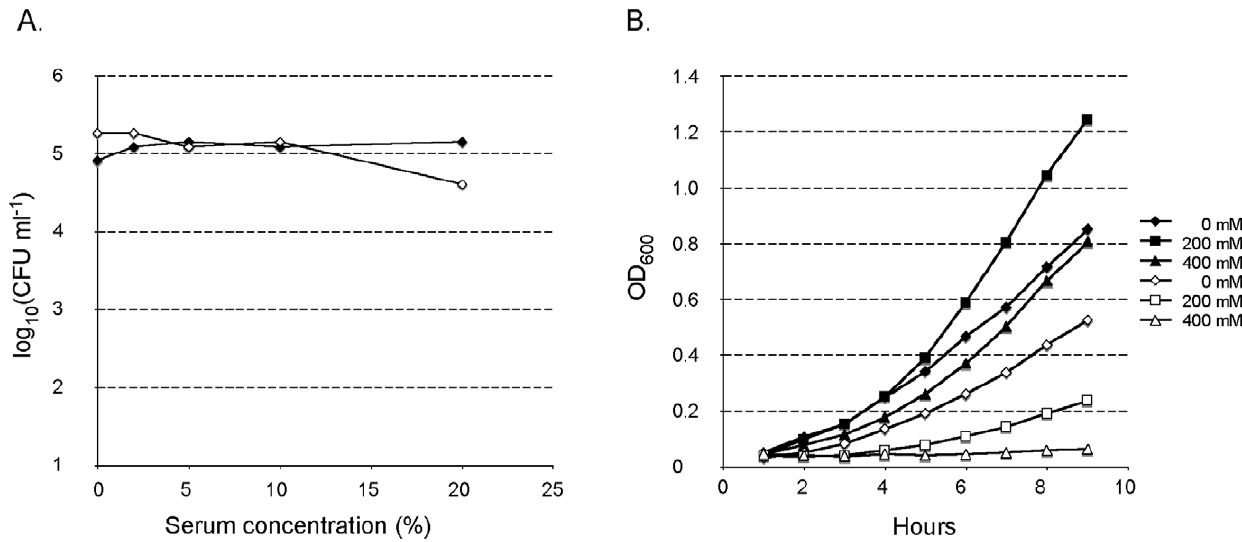
Figure 5. Resistance to serum and high osmolarity. Survival of LVS (closed symbols) and trkH mutant (open symbols) after 1 hour incubation in human non-decomplemented serum (0–20%) (A). Growth of LVS (closed symbols) and trkH (open symbols) in CDM supplemented with NaCl as indicated in legend (B).